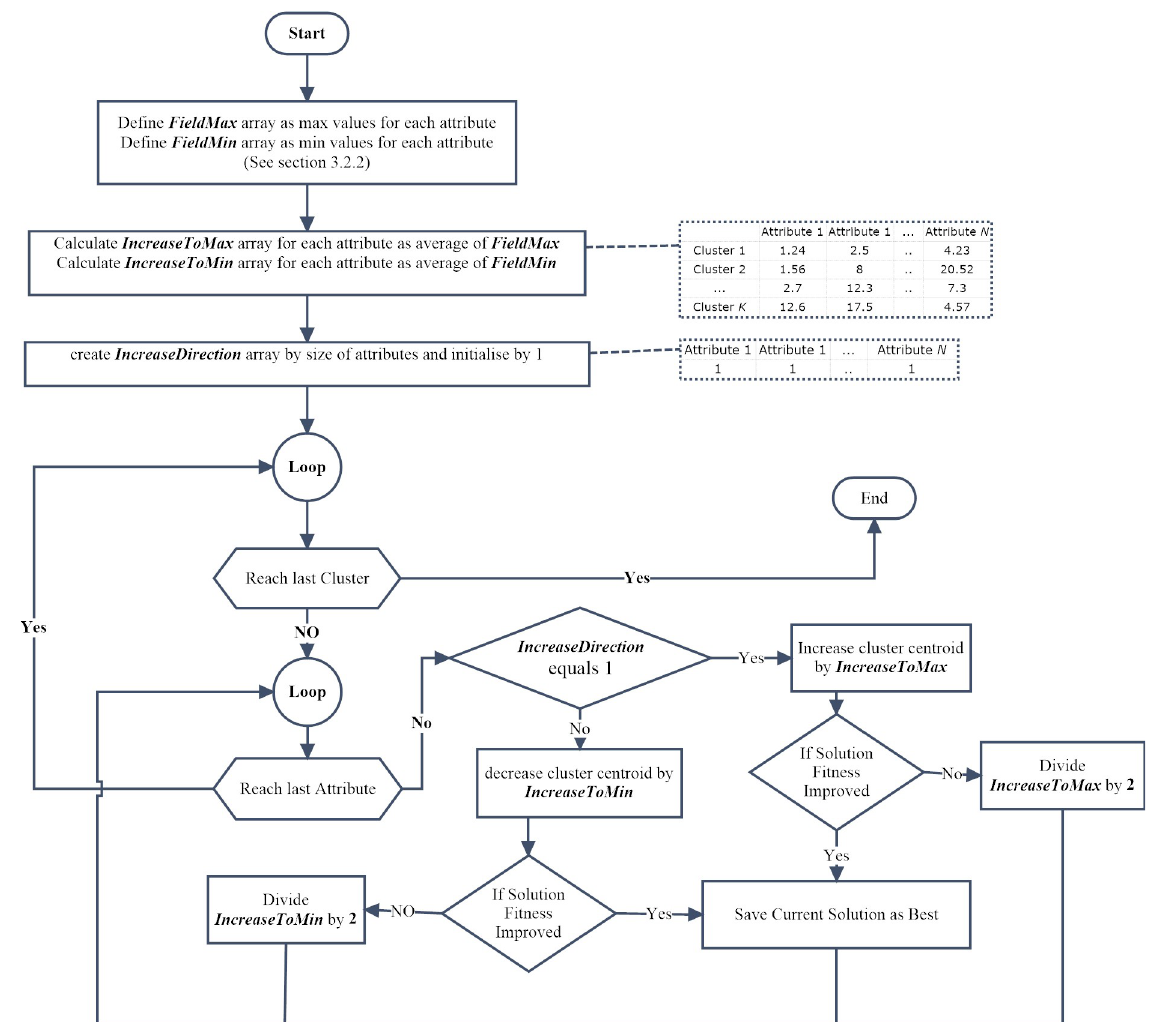
Fig 10. Flowchart of the neighbourhood selection